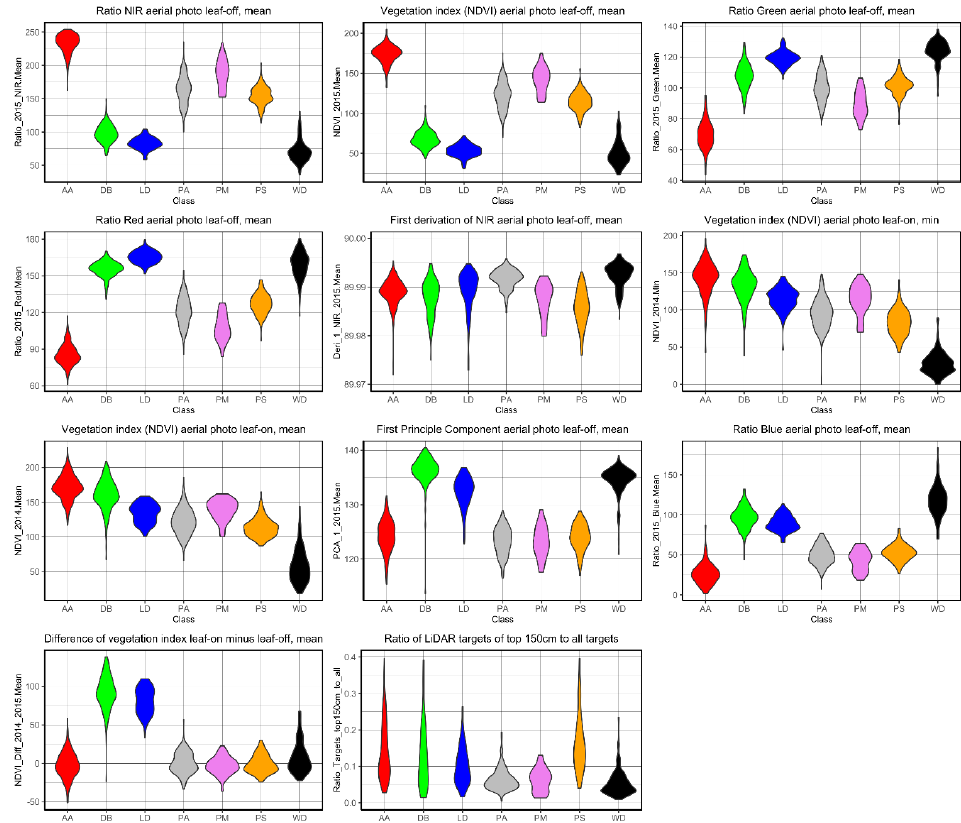
Figure 7. Violin plots showing the distribution frequencies of classified trees for the 11 variables implemented in the final classification model using the RF algorithm. Metrics of the multispectral data have been calculated from digital numbers and were rescaled to 8-bit range, hence the difference to reflectance-derived NDVI